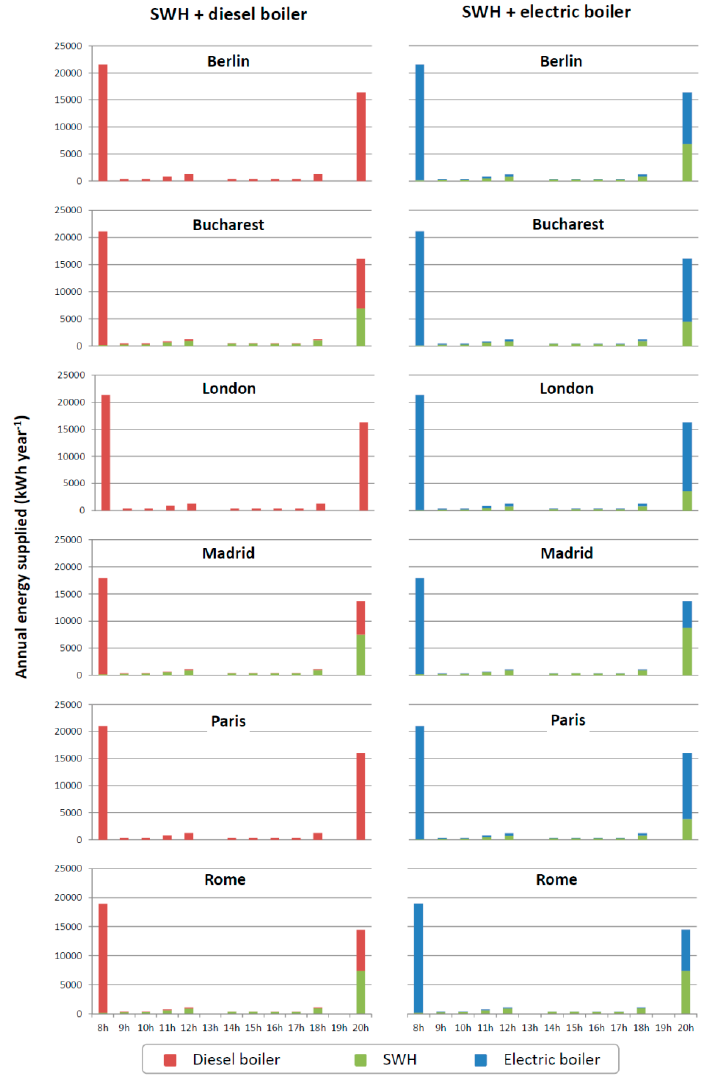
Figure 9. Annual energy provided by a different supply source in each of the time intervals. Table 2. Profitability indicators of the installation in the building of 10 homes. NPV: net present value; and IRR: internal rate of return.